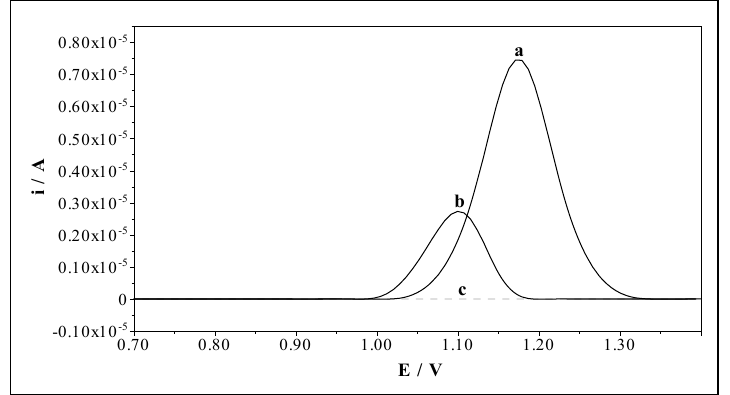
Figure 5. Differential pulse voltammograms for (a) 0.10 mM sulfamethoxazole at MIP electrode (b) 0.10 mM sulfamethoxazole at NIP electrode and (c) blank solution at MIP electrode in 50% (v/v) acetonitrile-water Britton-Robinson buffer at pH 2.5.